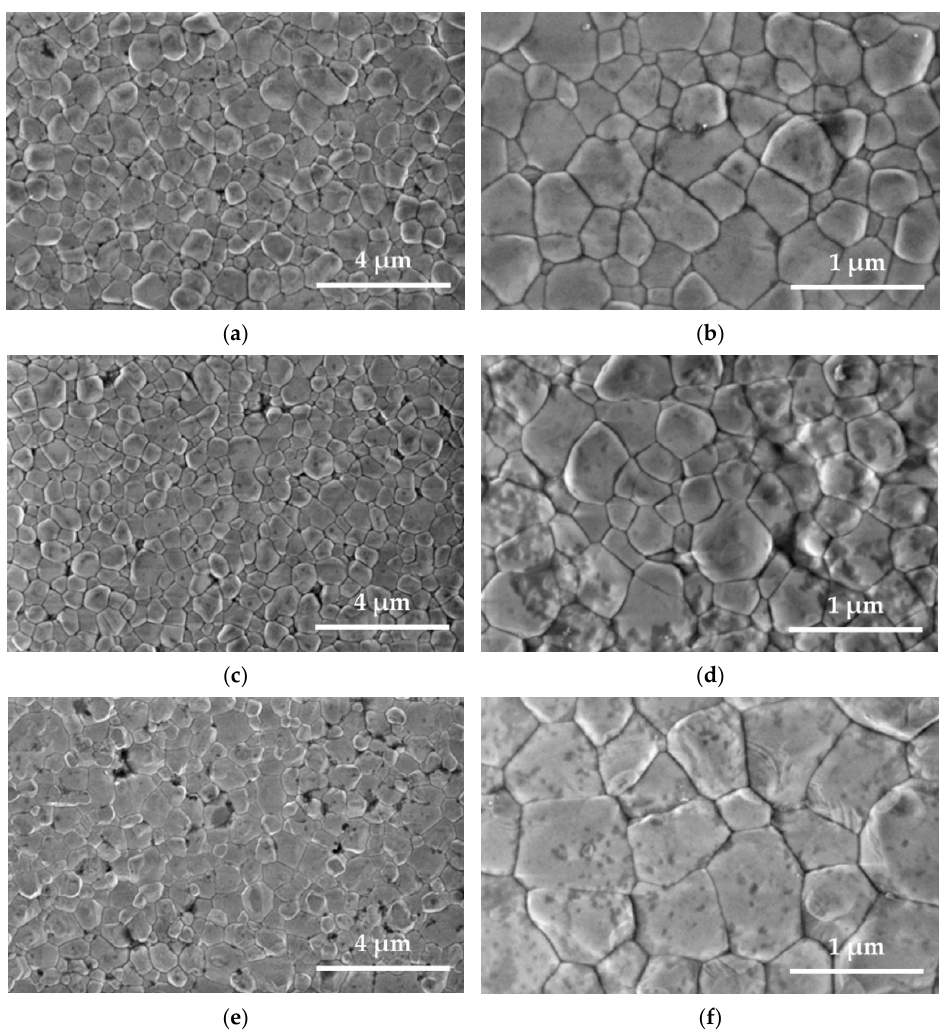
Figure 5. SEM micrographs of as-sintered zirconia surface at magnification × 25,000 (left) and magnification × 60,000 (right): 3Y specimen ( a , b ), 4Y specimen ( c , d ), and 5Y specimen ( e , f ). Table 2. Translucency parameter means (Mean TP) and standard deviations (SD) of different types of zirconia ceramics treated with APA and NAC. The same upper-case letters denote no statistical differences in TP values among the groups ( P <